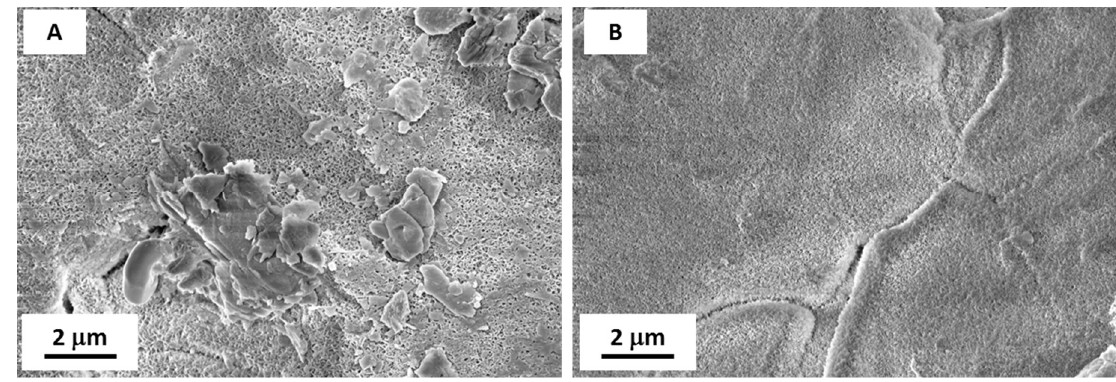
Figure 14. FE-SEM images of LF ( A ) and SLIPS samples ( B ) after 2 months of exposure in Karachi, Pakistan. Scale bars are reported.